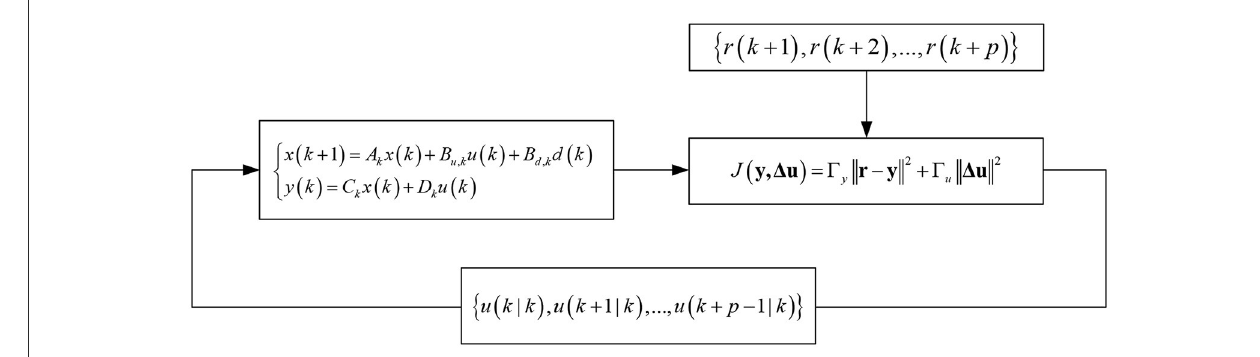
FIGURE12 LTV-MPC open-loop optimal solution.